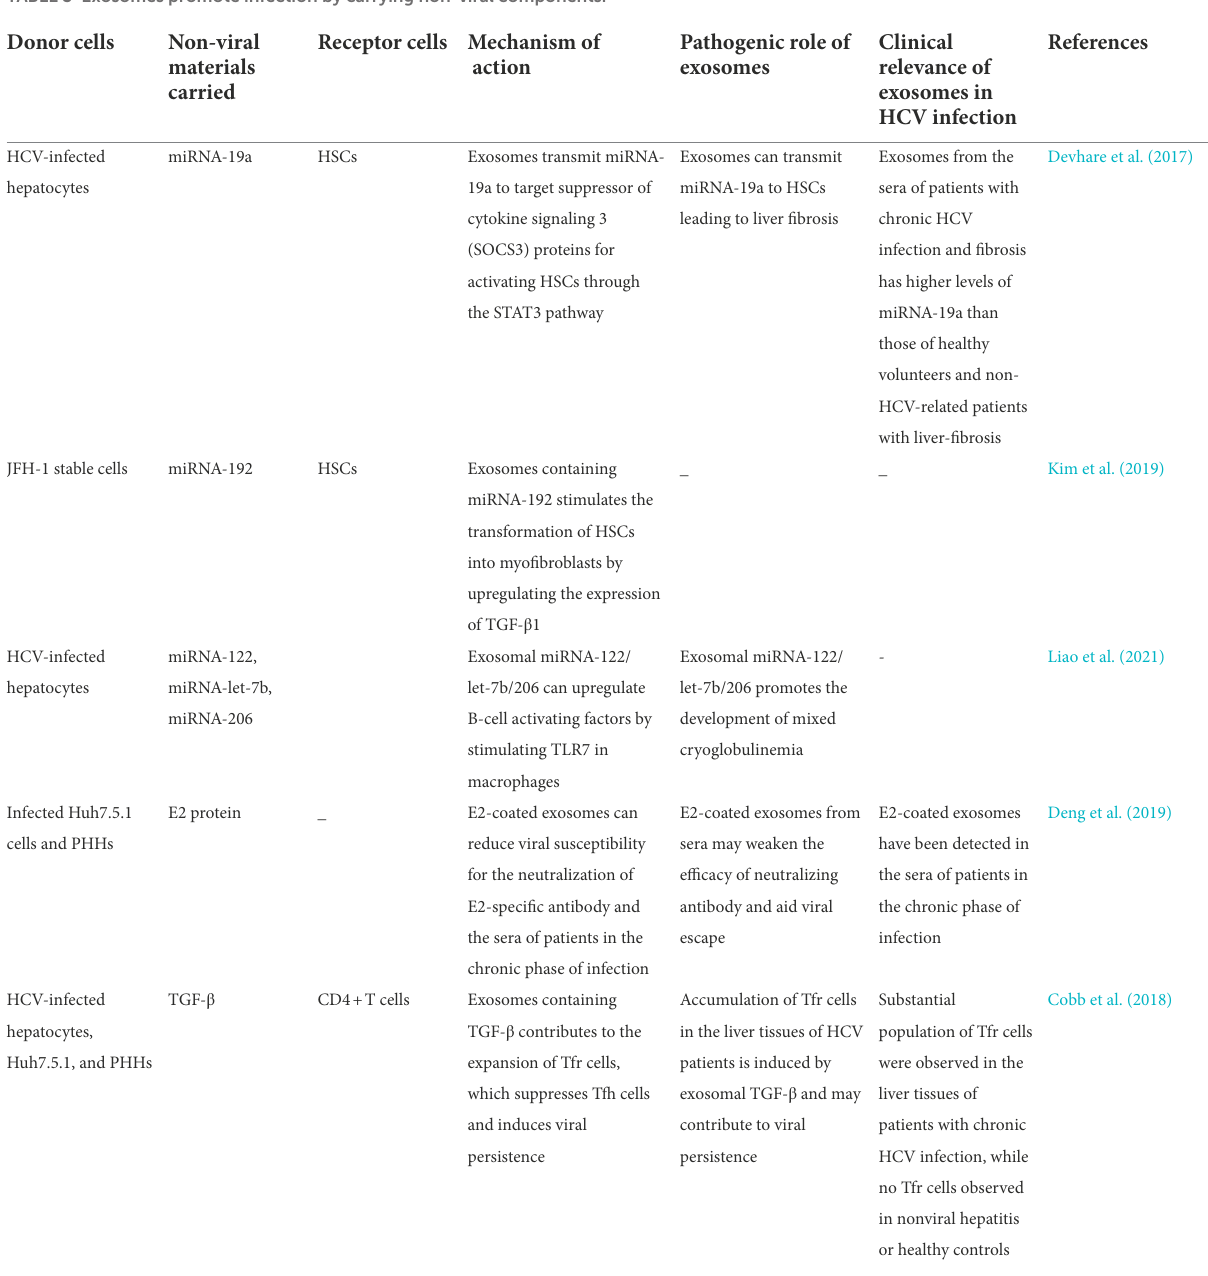
TABLE 3 Exosomes promote infection by carrying non-viral components. Donor